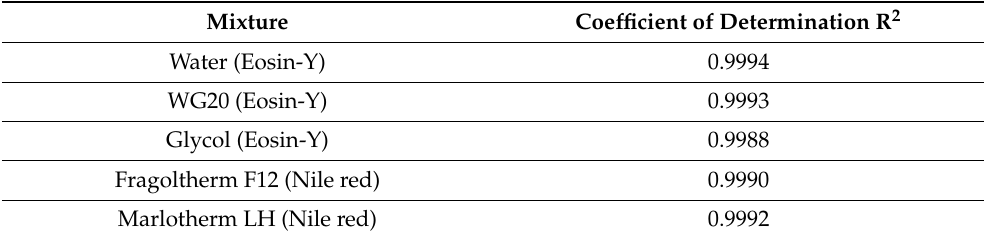
Table 2. Coefficients of determination R 2 for concentration-dependent absorption measurements.